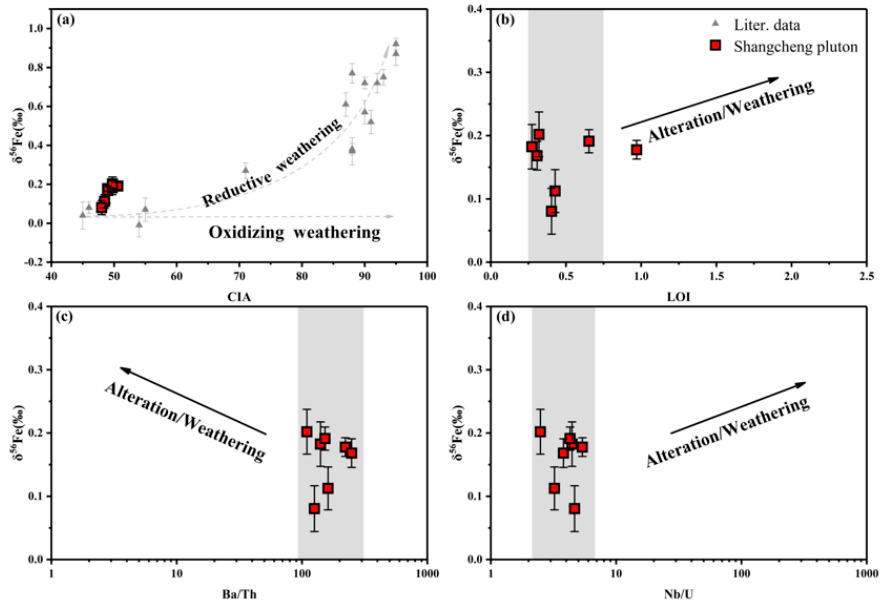
Figure 7. ( a ) CIA vs. δ 56 Fe, ( b ) LOI vs. δ 56 Fe, ( c ) Ba/Th vs. δ 56 Fe, ( d ) Nb/U vs. δ 56 Fe; data were taken from [17].